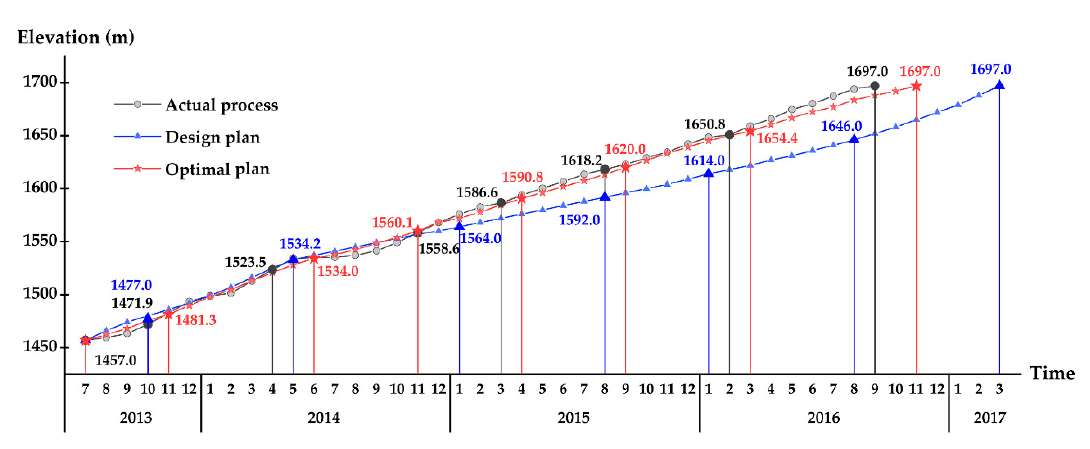
Figure 16. Optimization algorithm result comparison. ( a ) Curves of optimal fitness value; ( b ) Box diagram of calculation time; ( c ) Box diagram of optimal fitness.